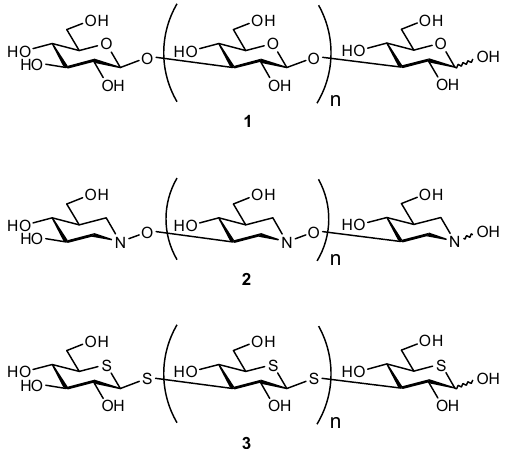
Figure 1. Oligosaccharide analogues to mimic β -(1 → 3)-glucan were synthesized as inhibitors of complement receptor 3 (CR3) and dectin-1, targeting the regulation of phagocytosis [75,76]. Cyclic phosphonates (‘phostones’) and phosphinates (‘phostines’) have also been used as